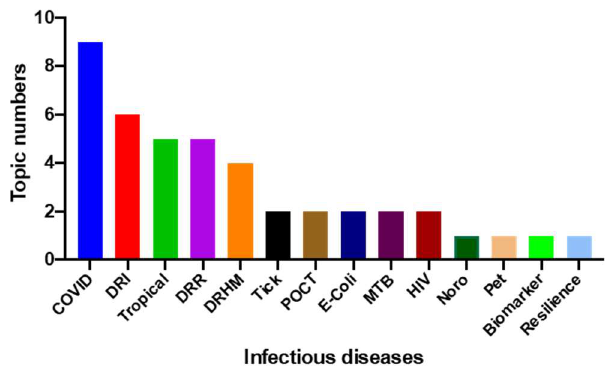
Figure 1. The topic classification of seminar contents. Abbreviation: COVID, COVID-19; DRI, Disaster-related infectious disease; Tropical, Tropical infectious diseases; DRR, Disaster-risk reduction; DRHM, Disaster-risk health management; Tick, Tick-borne diseases; POCT, Point of care test; E. coli , Escherichia coli ; MTB, Mycobacterium tuberculosis ; HIV, Human immunodeficiency virus; Noro, Norovirus; Pet, Pet-derived infectious diseases.